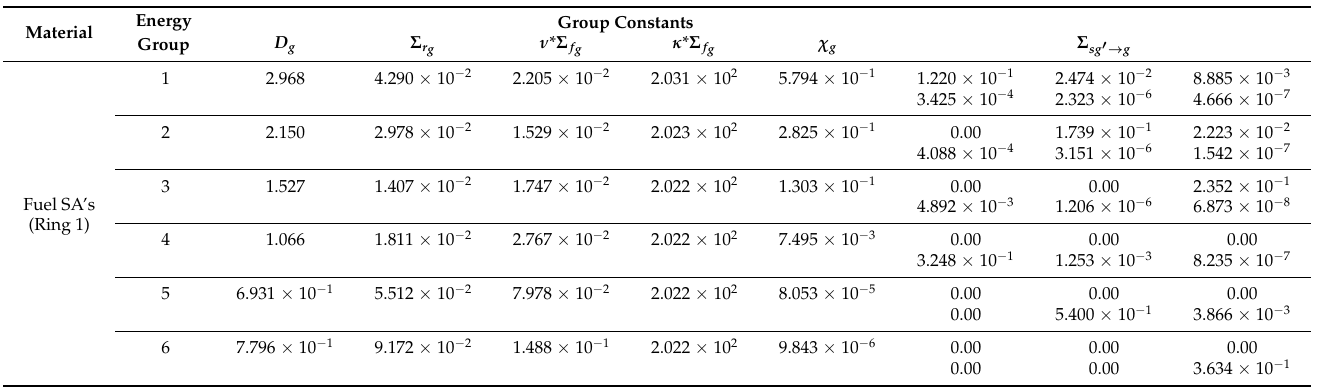
Table 3. Group constants generated with